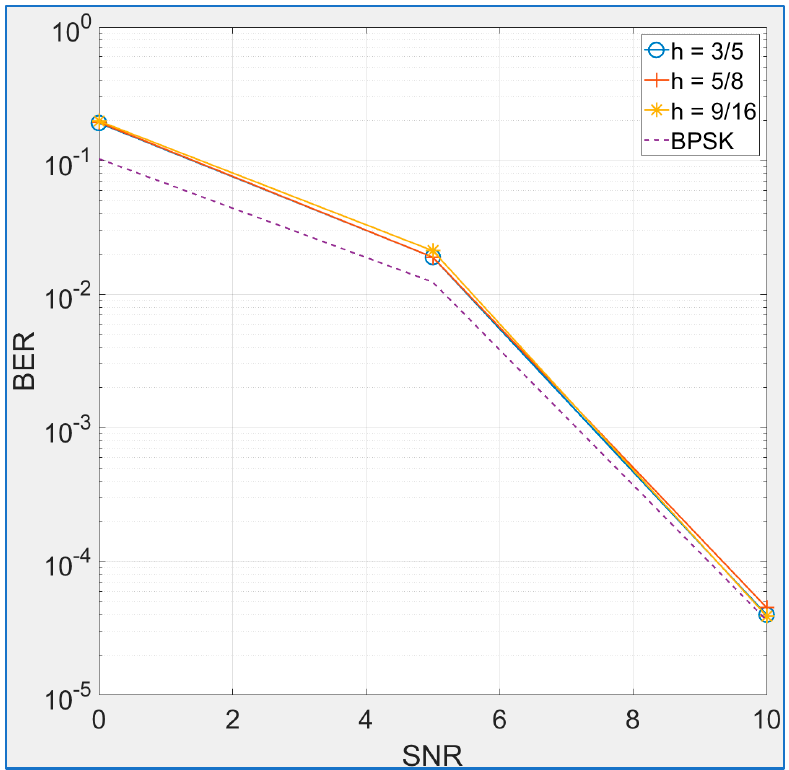
Figure 7. BER performance of binary CPM-GFDM vs. BPSK-GFDM for zero forcing receiver over AWGN channels.